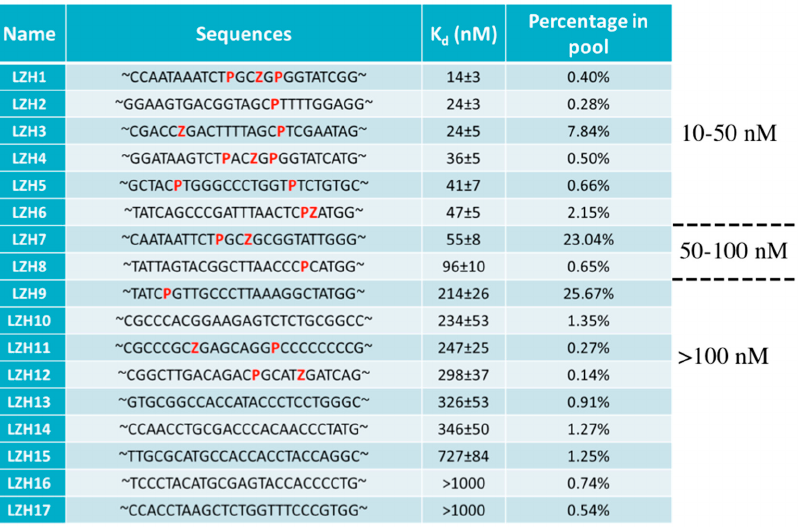
Figure 4. Sequences and k d of aptamers evolved from AEGIS-Cell-SELEX against liver cancer cells. Percentage in the pool indicates the relative amounts of a particular sequence to the total sequences analyzed from cycle 13. AEGIS nucleotides are in red. Adapted from [93].